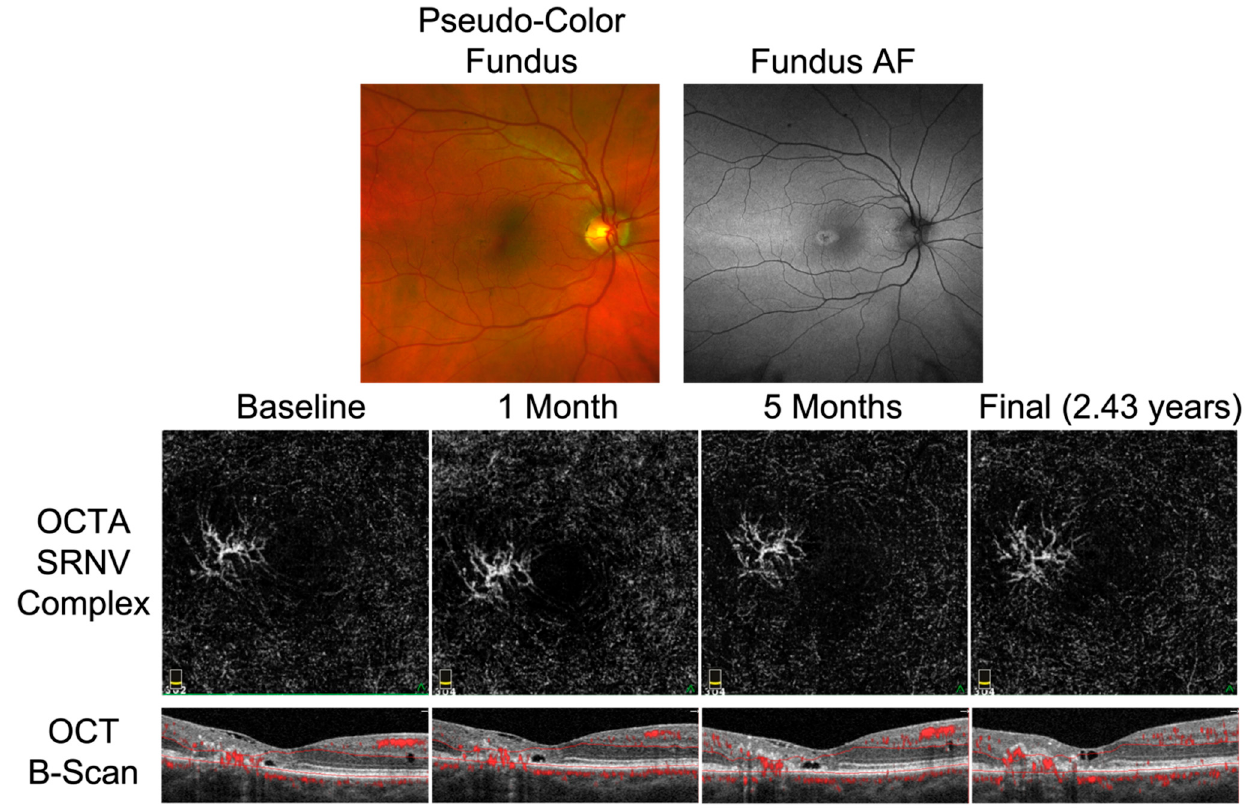
Figure 3. Response of subretinal neovascularization (SRNV) to treatment, as tracked by OCTA imaging of the outer retina. Baseline pseudo-color fundus and fundus autofluorescence (AF) imaging shown for reference, demonstrating a secondary neovascular membrane in the temporal macula. The right eye of patient D was treated with intravitreal bevacizumab at 1 and 5 months after baseline presentation. The SRNV complex, located in the temporal aspect of the outer retina, displays stability with respect to its size and location during treatment and continued monitoring. OCT B-scans through the central fovea shown at bottom, with overlying flow in red.